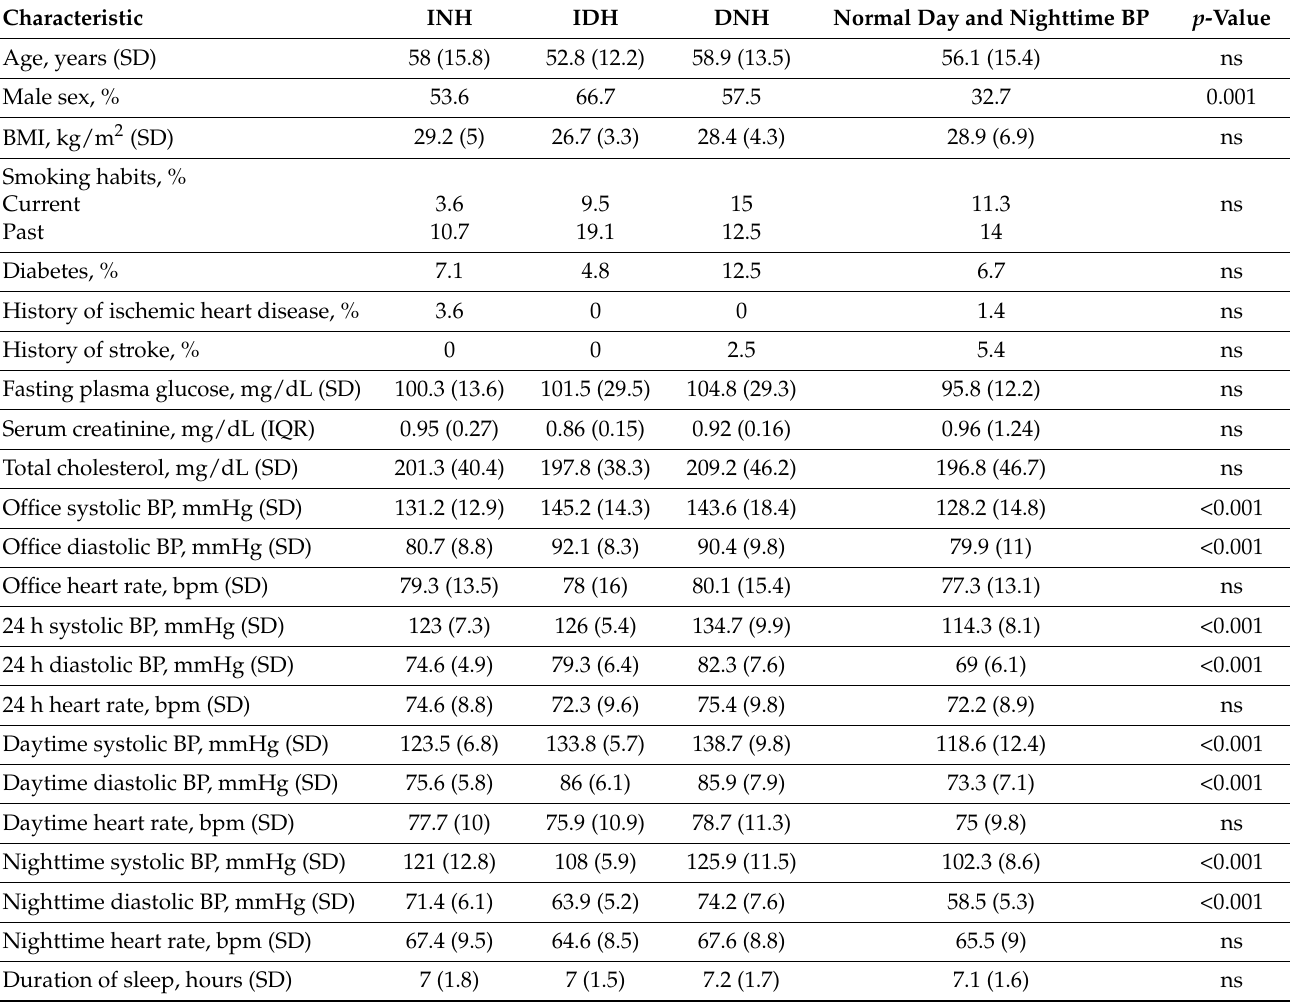
Table 5. Comparison between subjects with isolated nocturnal hypertension, isolated diurnal hyperten- sion, day and nighttime hypertension, and day and nighttime normal BP among untreated